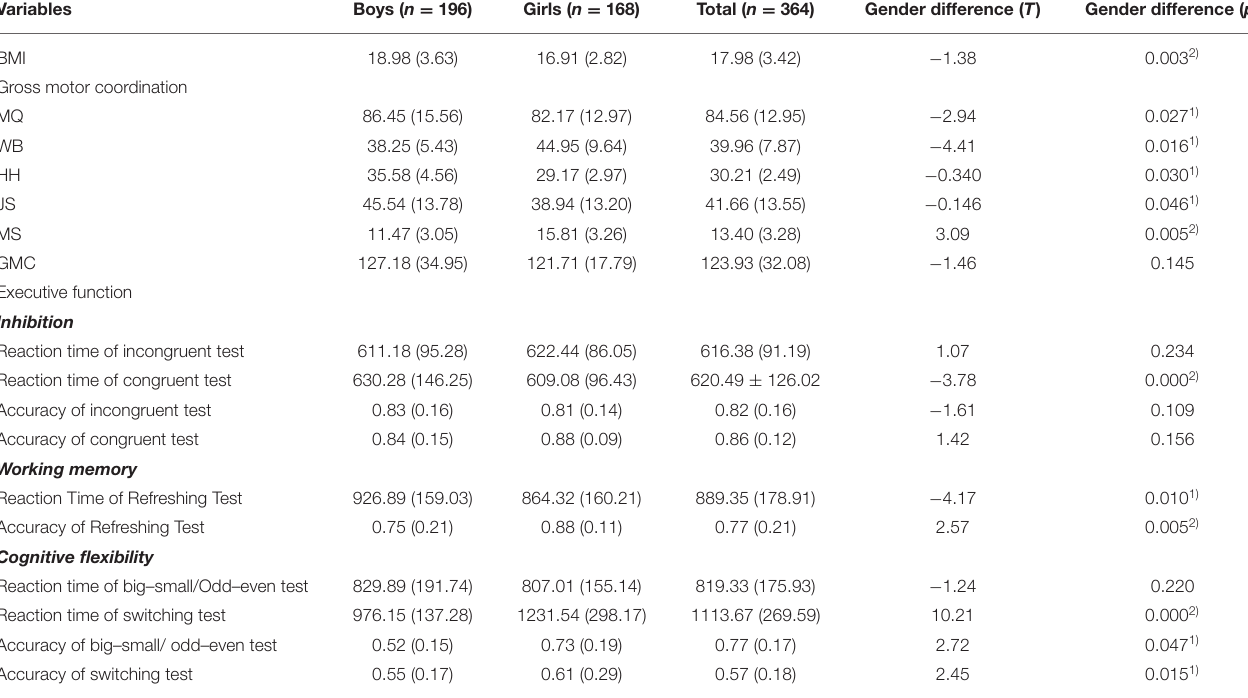
TABLE 1 | Descriptive statistics of gross motor coordination and executive function of children aged 9–10 years.